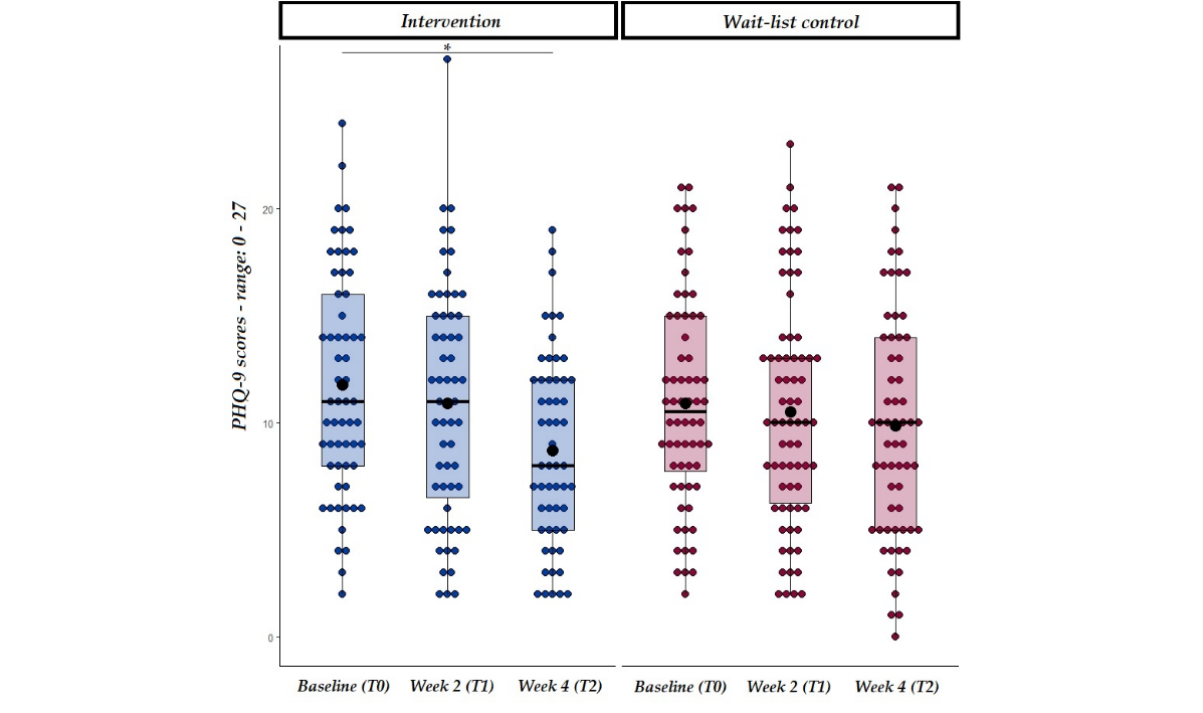
Figure 5. PHQ-9 scores at baseline and week 2 from the start of the intervention in both intervention and wait-list control groups. Solid